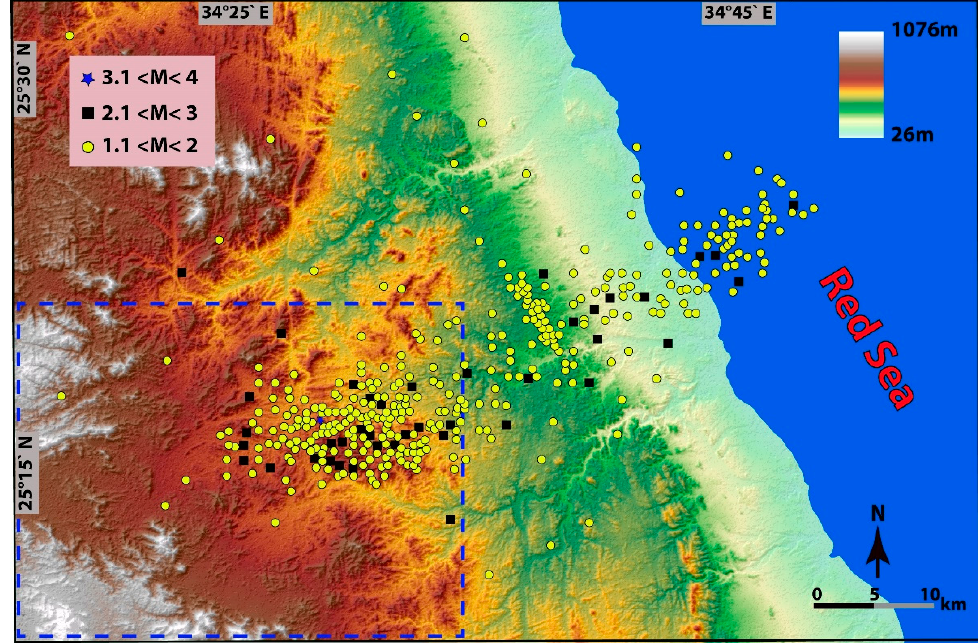
Figure 3. Seismicity map of the study area and surroundings showing earthquakes between October 2008 and April 2010, modified after [48]. Blue dashed rectangle shows the study area.